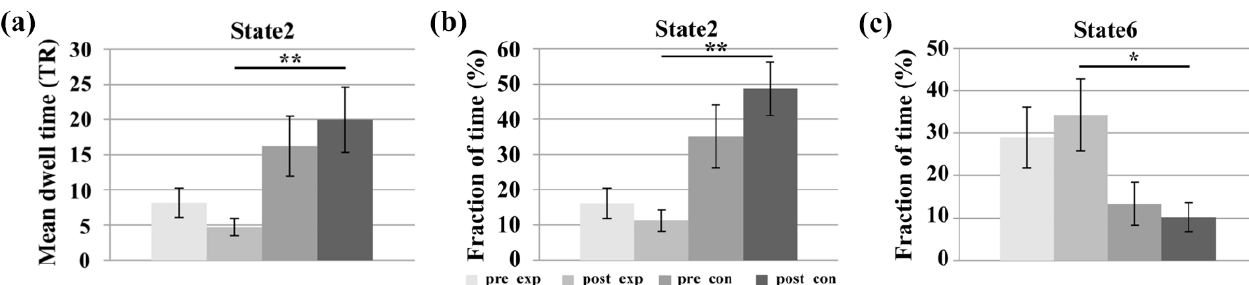
Figure 4. Time measurements for the pre-training and post-training ME runs of the two groups. ( a ) The mean dwell time of state 2, ( b ) the fraction of time of state 2, and ( c ) the fraction of time of state 6. Pre_exp represents the pre-training run of the experimental group. Post_exp represents the post-training run of the experimental group. Pre_con represents the pre-training run of the control group. Post_con represents the post-training run of the control group. Error bars represent the standard error (* p < 0.05; ** p < 0.01).